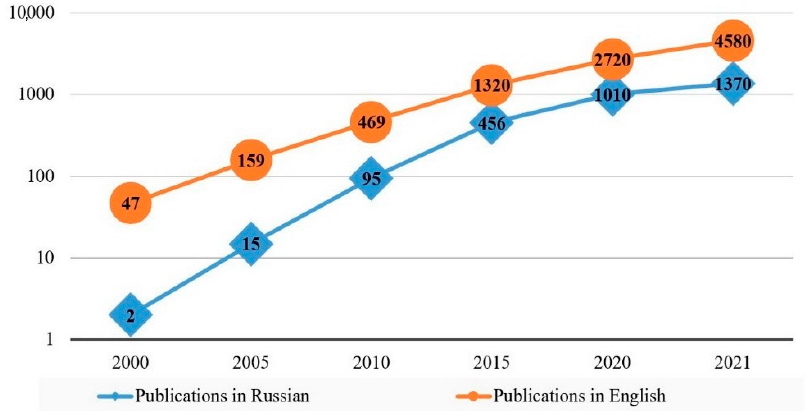
Figure 1. Dynamics of changes in the number of Russian and English publications focused on the concept of transhumanism in the Google Scholar system. Source : own development based on the analysis of Google Scholar data.